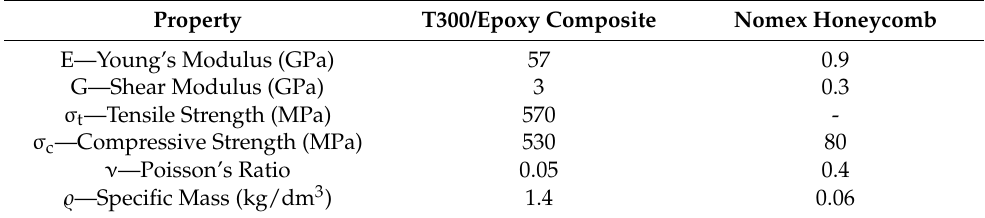
Table 1. Mechanical properties of carbon fiber laminate and Nomex honeycomb.